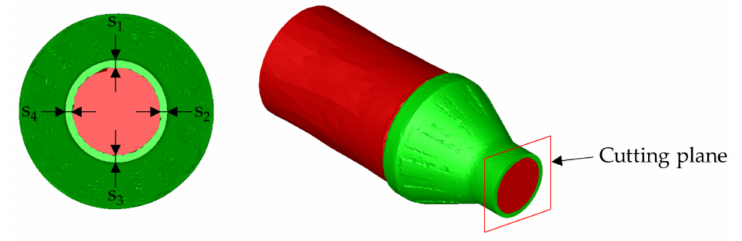
Figure 6. Measuring points in the simulations.